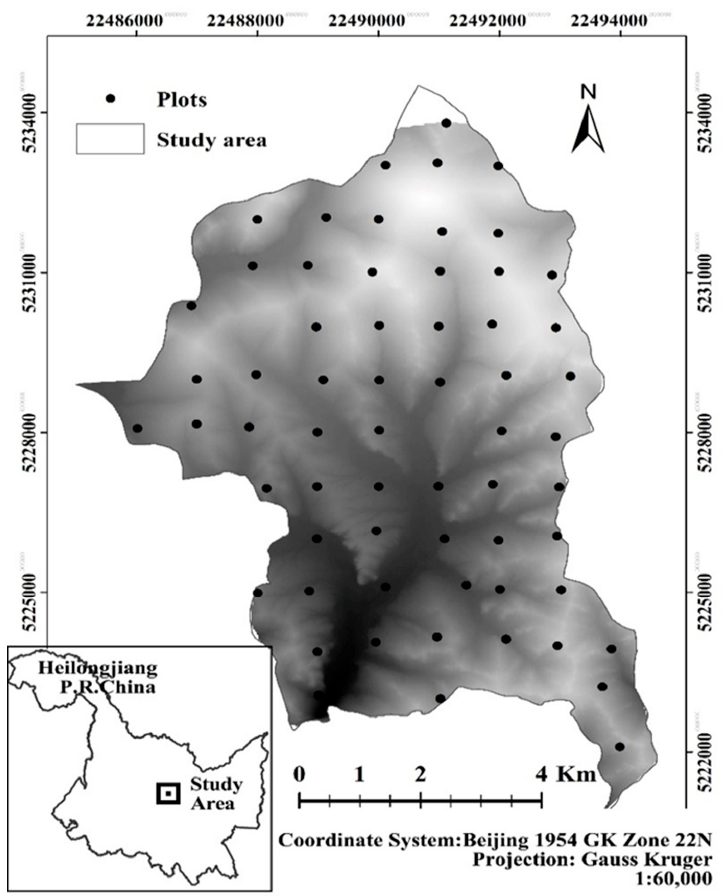
Figure 1. Location of the study area and 62 sampling plots.